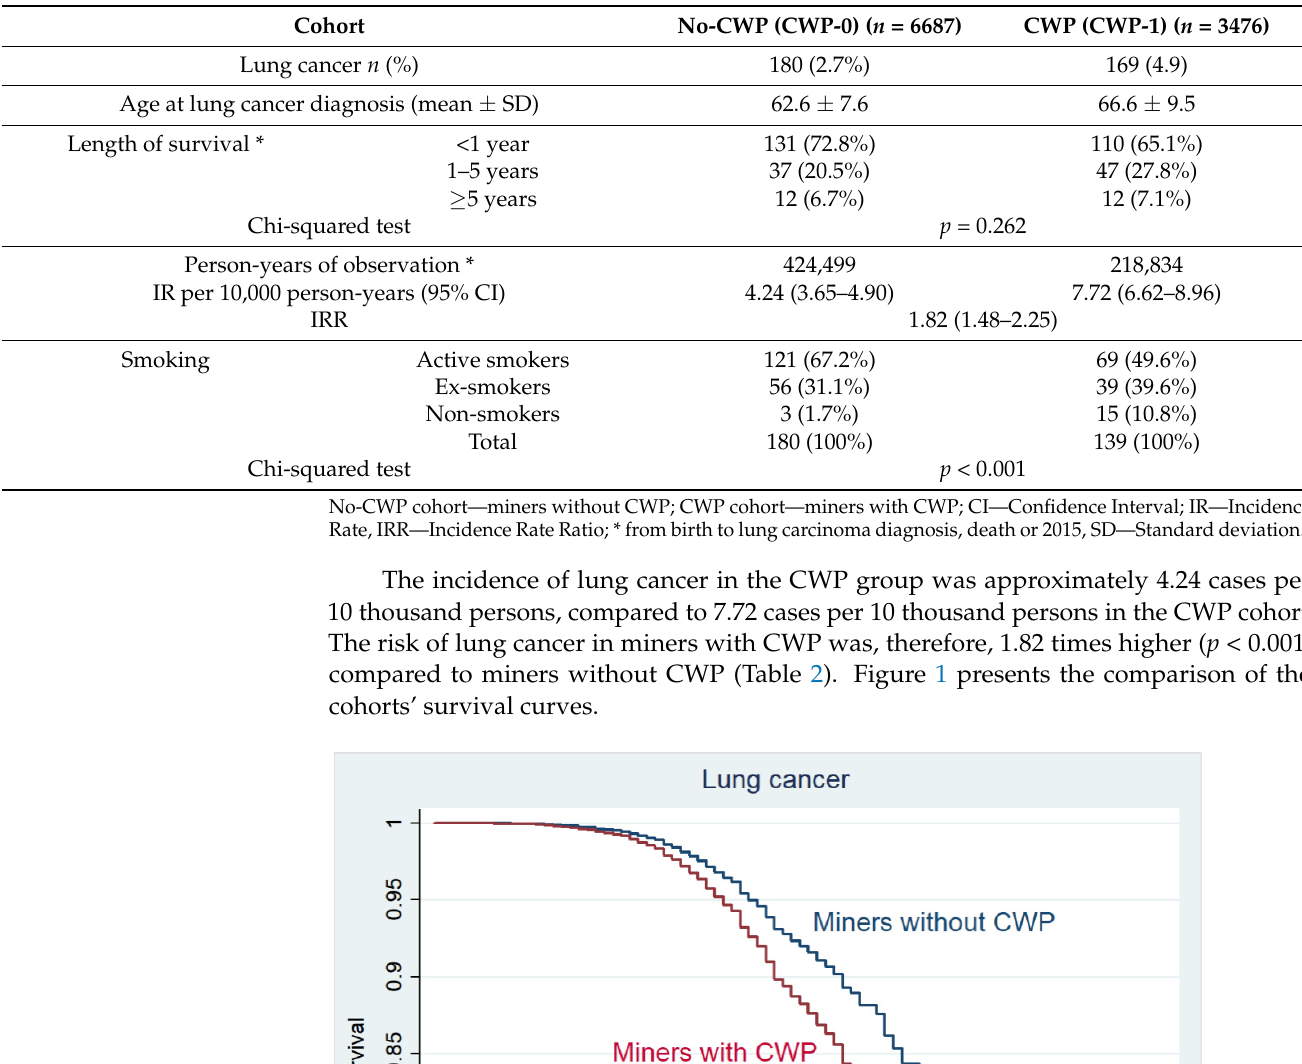
Table 2. Description of miners without/with coal-workers’ pneumoconiosis (CWP) and lung cancer.